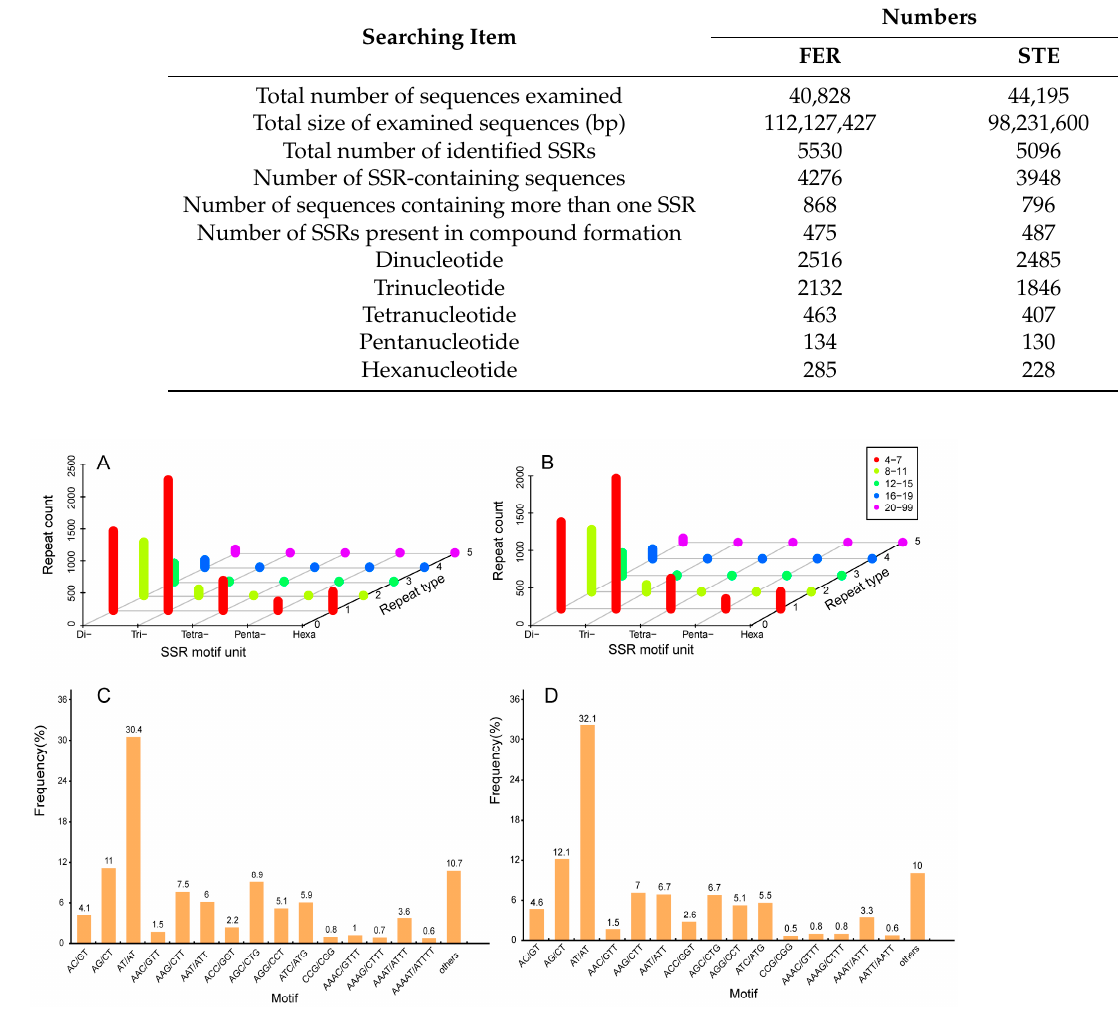
Table 1. Summary of SSRs identified in P. tabuliformis transcriptome of FER and STE ovule.